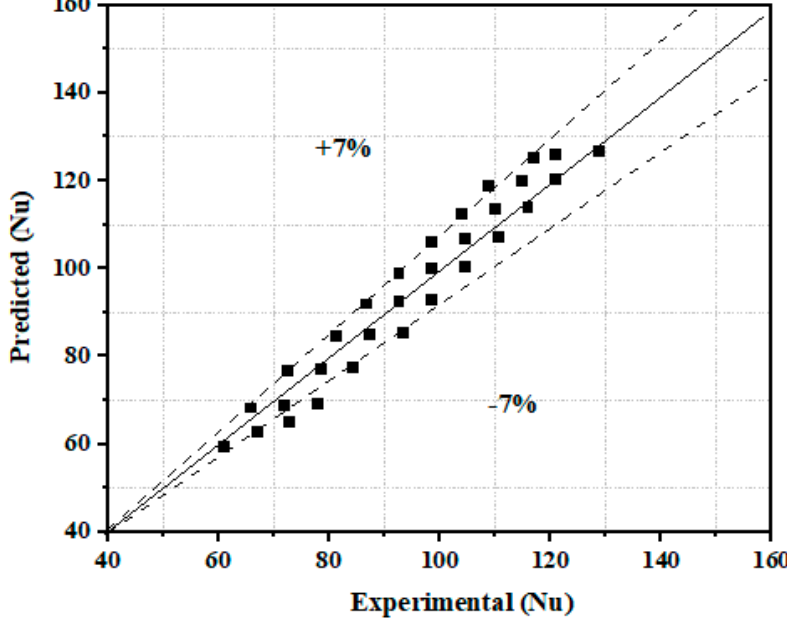
Figure 10. Expected data of Nu vs. trial data.